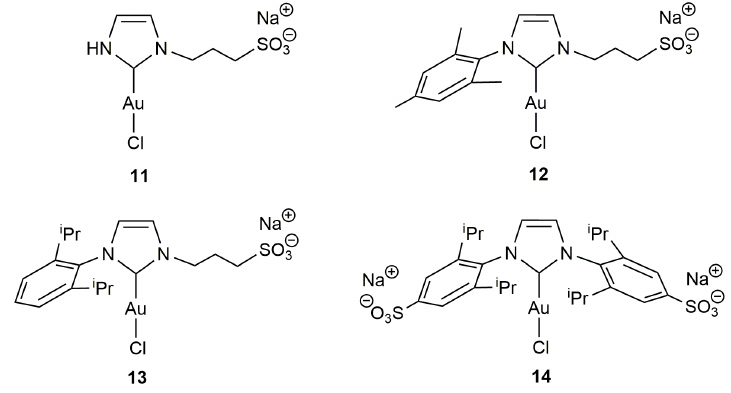
Figure 2. Structure of the water-soluble NHC-Au(I) complexes 11 – 14 .